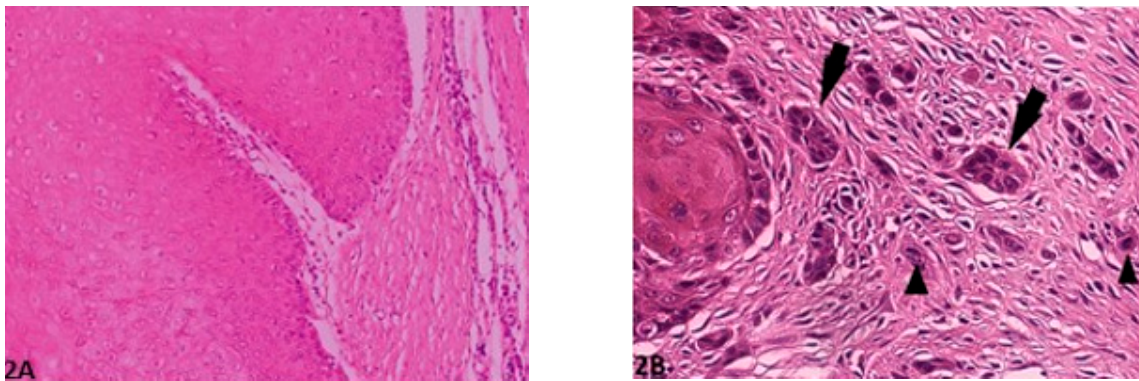
Figure 2. Pattern of invasion: ( A ) (O.M. 8 × ): Well-differentiated, expansively growing tumor borders compressing the surrounding stroma (Golden Retriever, No. 87); ( B ) (O.M. 20 × ): Wide-spread cellular dissociation in small groups (<15 cells, arrow) and/or single cells (arrow heads, medium Schnauzer, No. 45). O.M: original magnification.